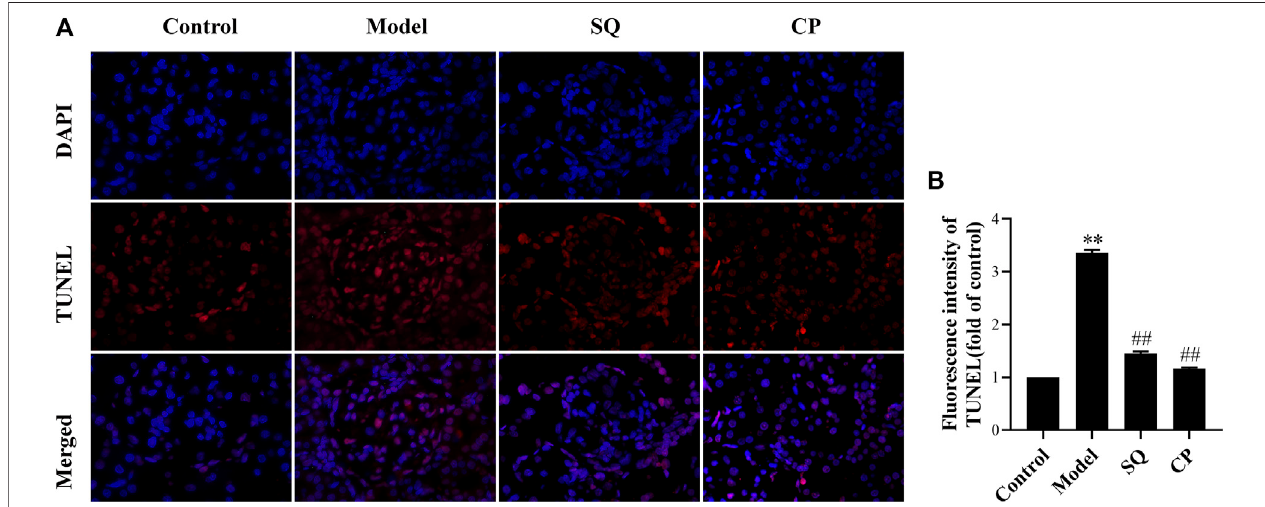
FIGURE4| SQrestrained podocyteapoptosis inPHN rats(magni fi cation × 200). Kidneyparaf fi nsliceswerestained byTUNELassaywithlabeled dUTP and DAPI dye (A) . Podocyte apoptosis (B) in PHN rats effectively deteriorated with the treatment of SQ and CP ( n (cid:1) 6). Data are represented as mean ± SD from independent groups. ** p < 0.01 vs. Control group. ## p < 0.01 vs. Model group.